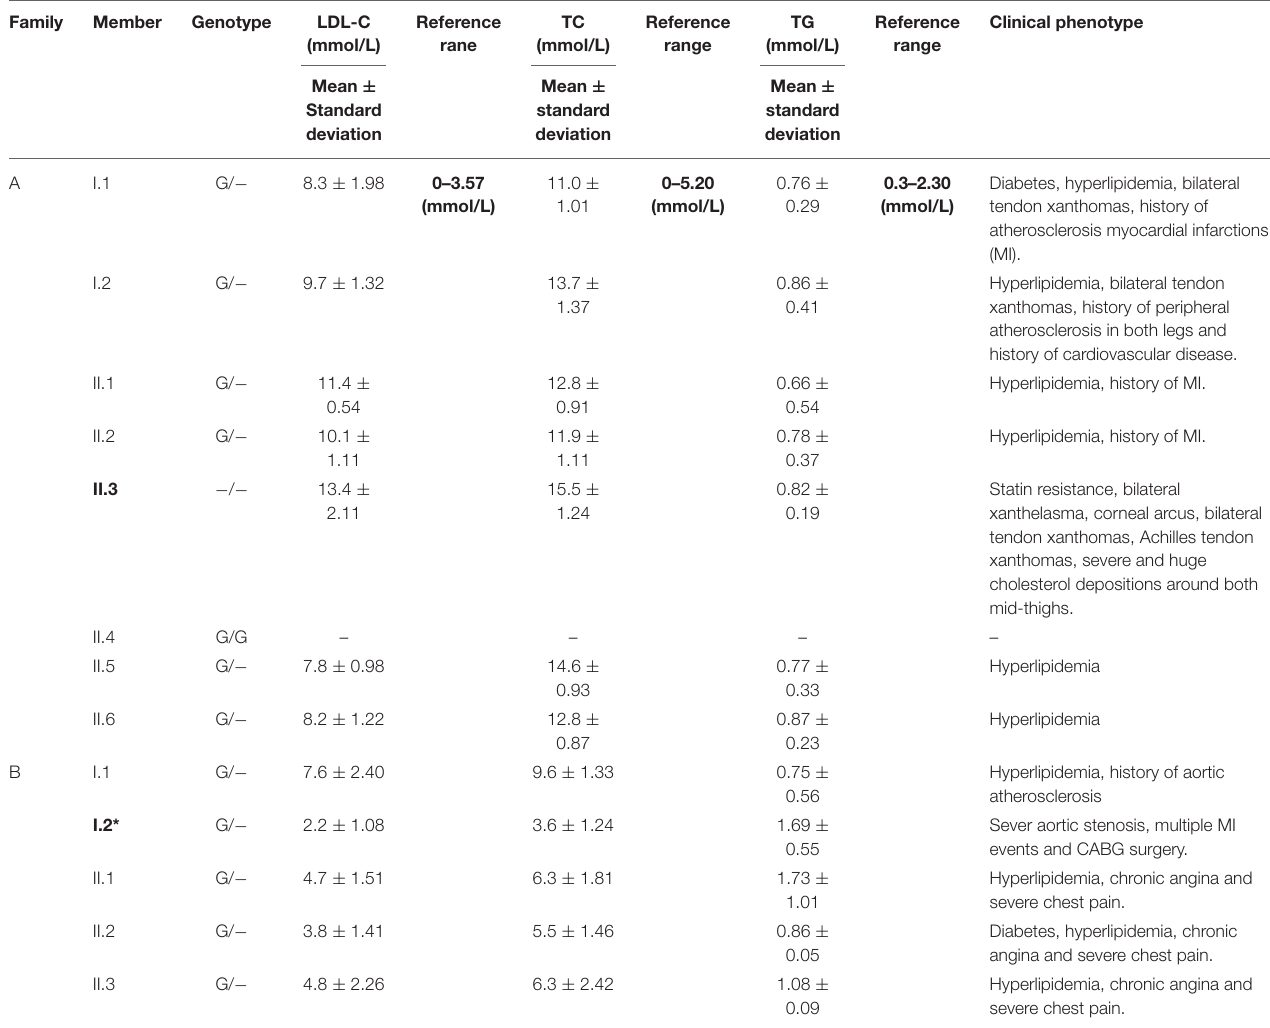
TABLE 1 | Clinical and biochemical characteristics of FH families studied in this investigation.